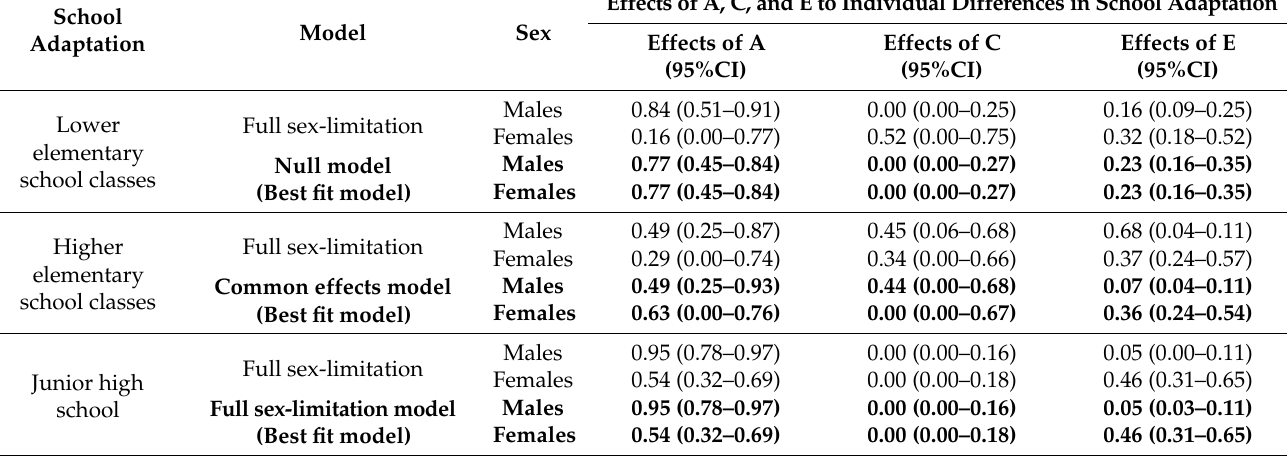
Table 8. Parameter estimates of school adaptation from sex-limitation model fitting.